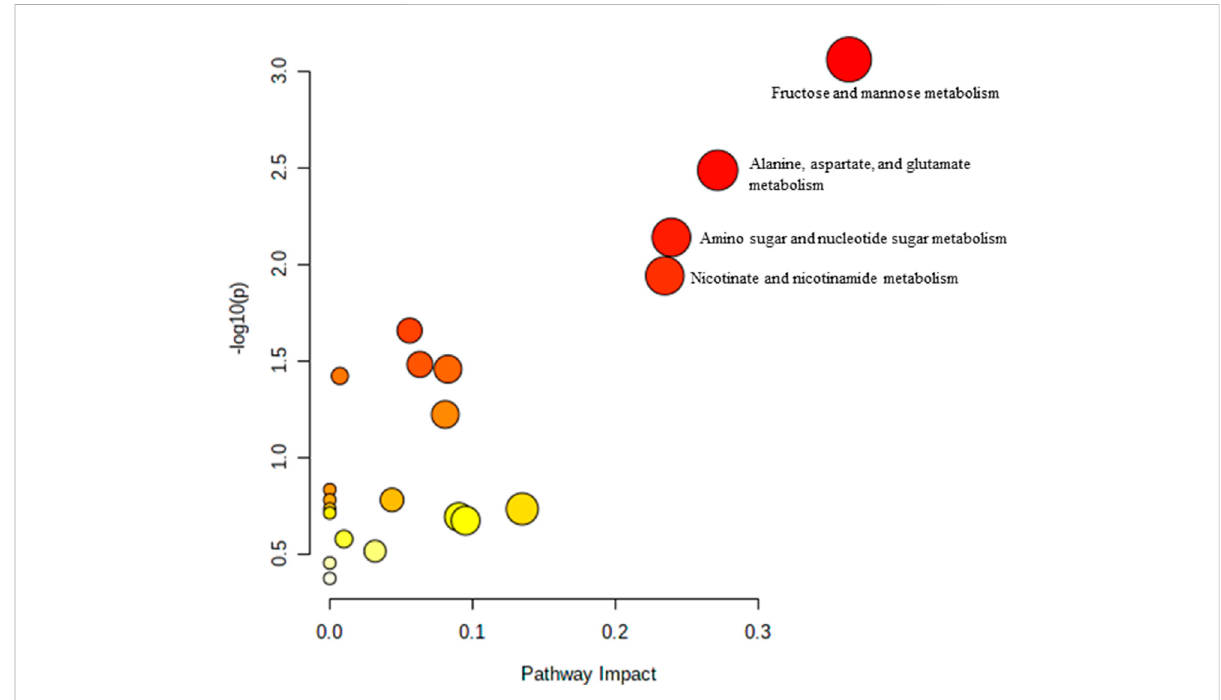
FIGURE 6 Biochemical pathway analysis of metabolites pro fi led for AC vs. AT.